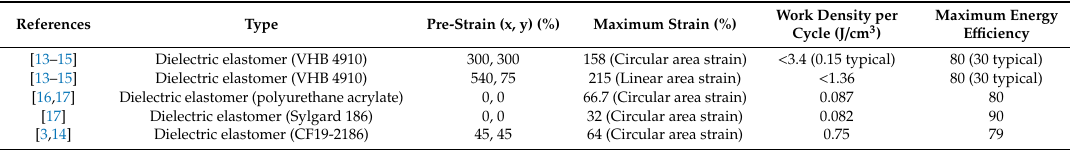
Table 1. Comparison of the properties of